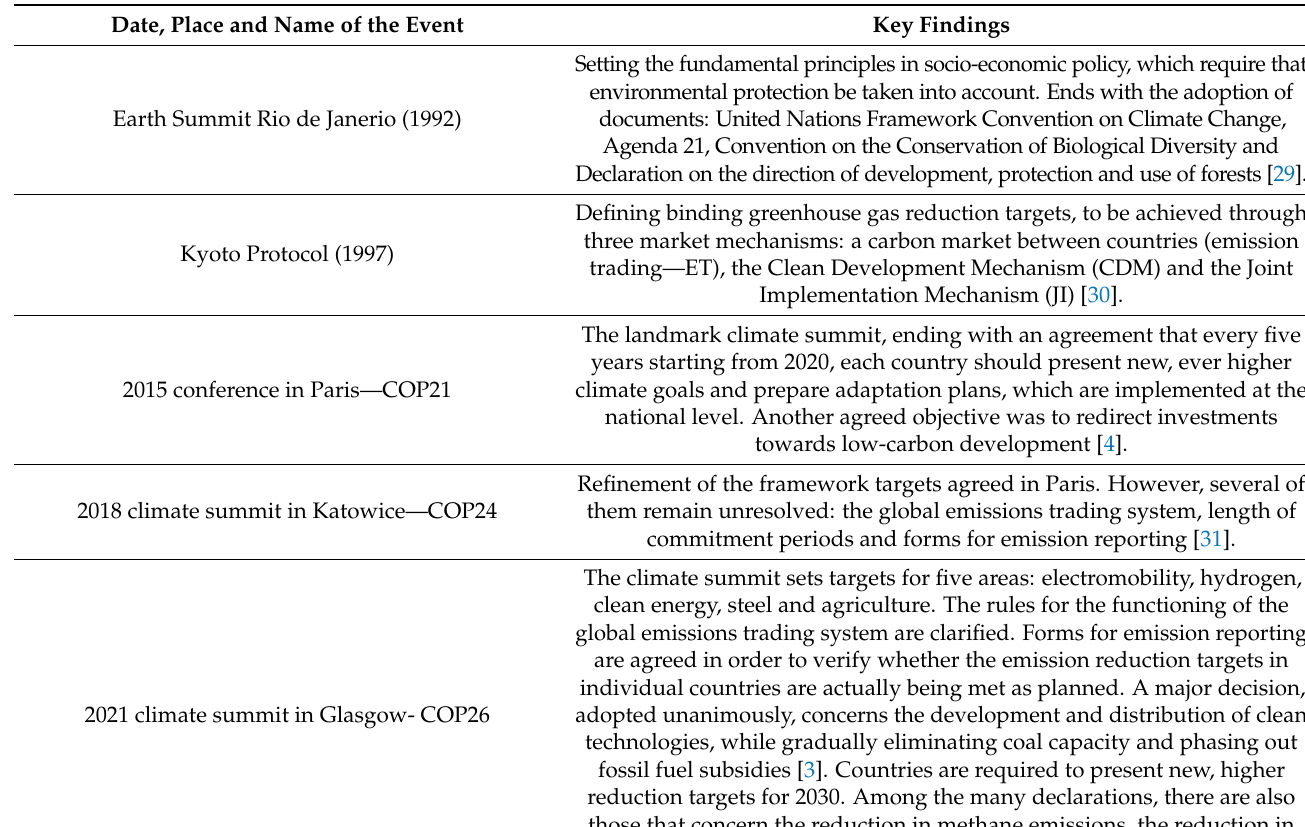
Table 2. The most important summits and findings regarding climate